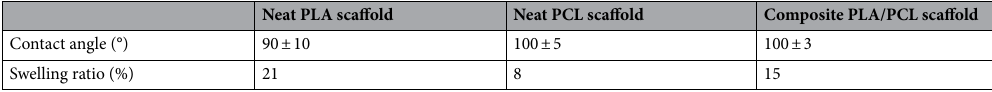
Table 3. Contact angle and swelling ratio of the melt electrowritten scaffolds (number of samples for each measurement = 3) (statistical analysis with one-way ANOVA shows statistical significance with p-values less than 0.001).